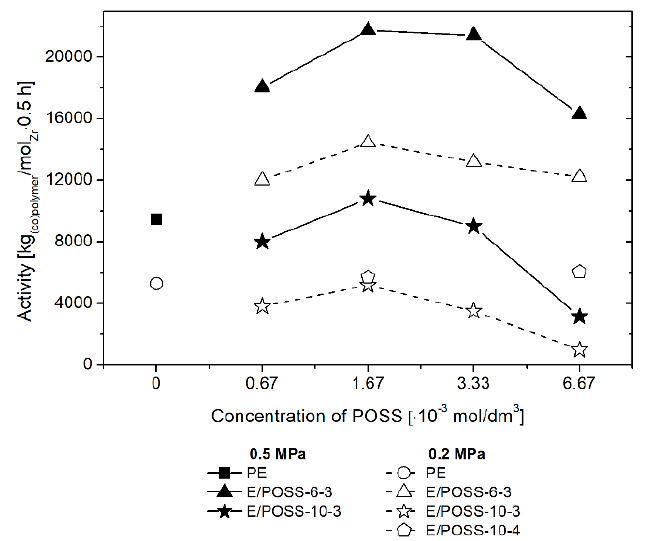
Figure 2. Effect of polyhedral oligomeric silsesquioxanes (POSS) comonomer on performance